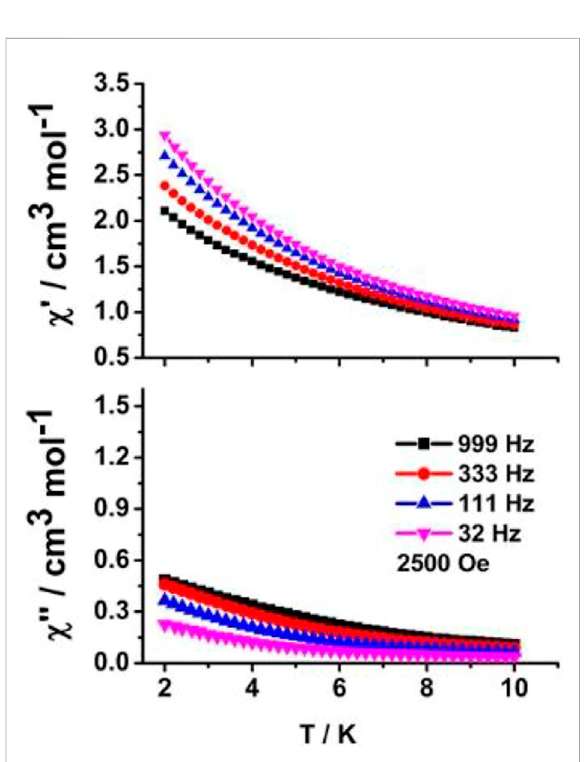
FIGURE 7 Temperature-dependent in-phase ( χ ′ ) (up) and out-of-phase ( χ ’’ ) (down) ac susceptibility curves under H dc = 2,500 Oe of 1 .